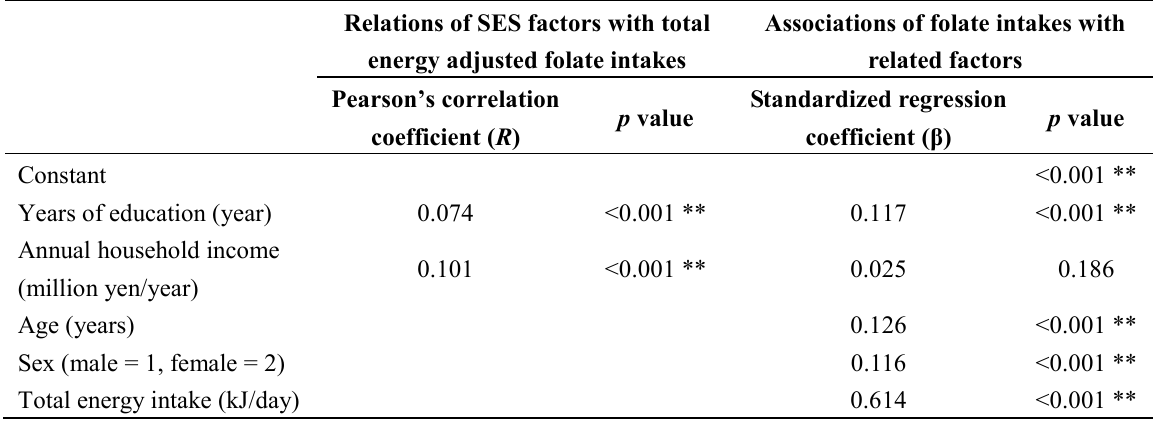
Table 3. The associations of daily dietary intakes of folate with SES factors (years of education and adjusted annual household